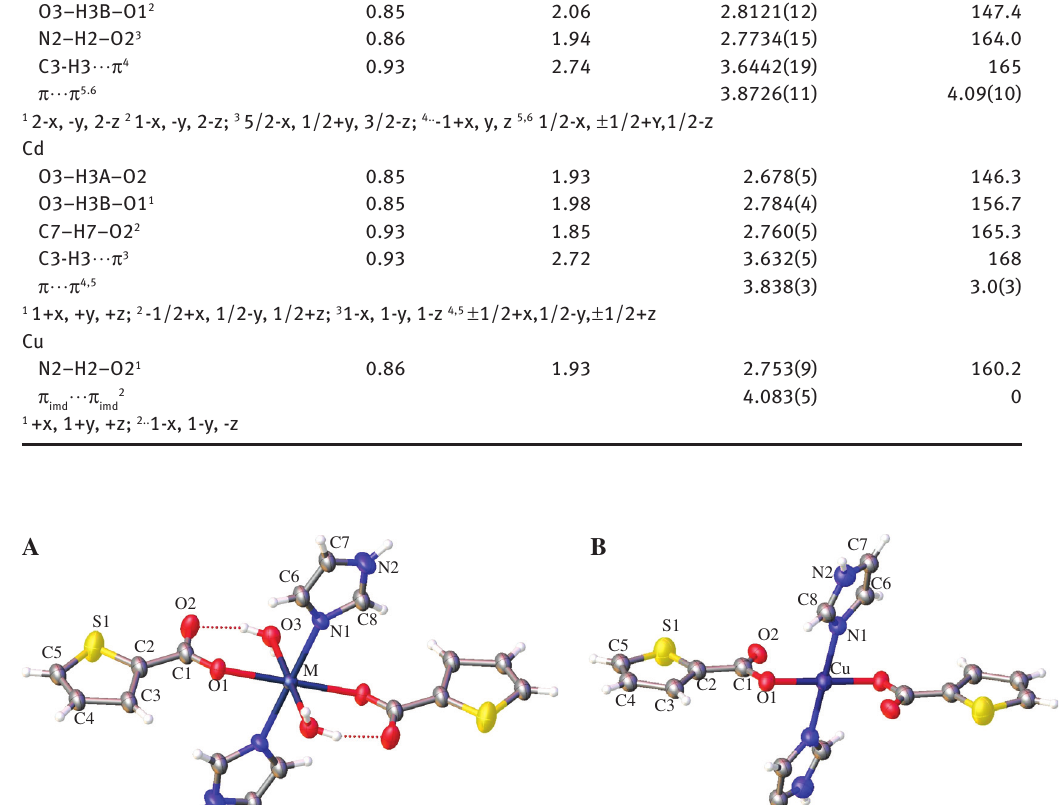
for Cd(II) = 3167 cm -1 and for Cu(II) = 3139 cm -1 ]. The